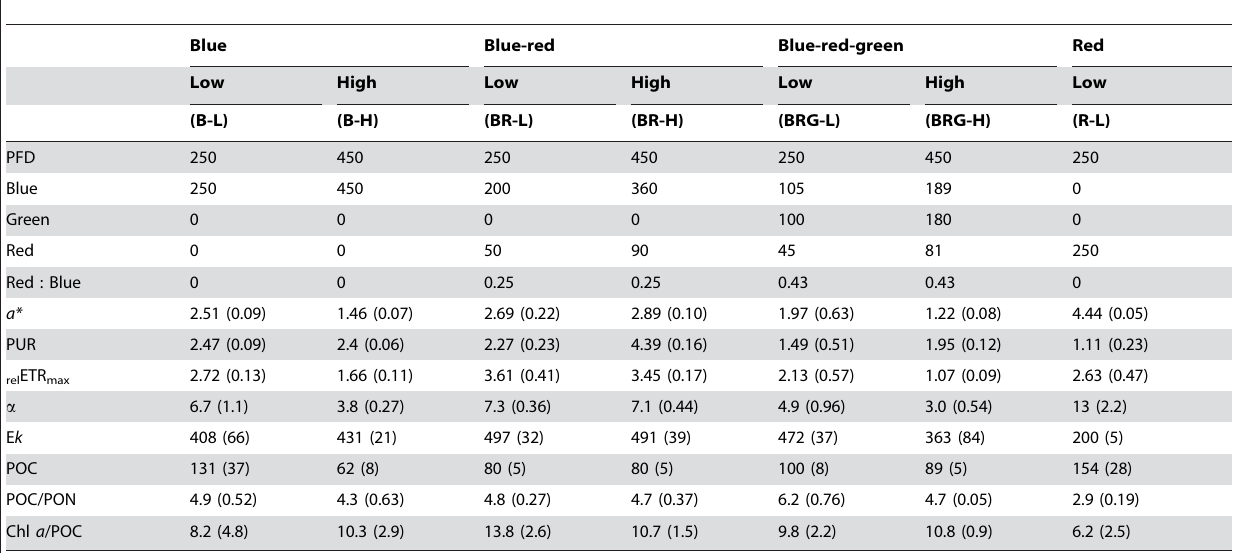
Table 1. Light condition characteristics, and photosynthetic and biochemical properties in Pseudo-nitzschia multistriata cells.